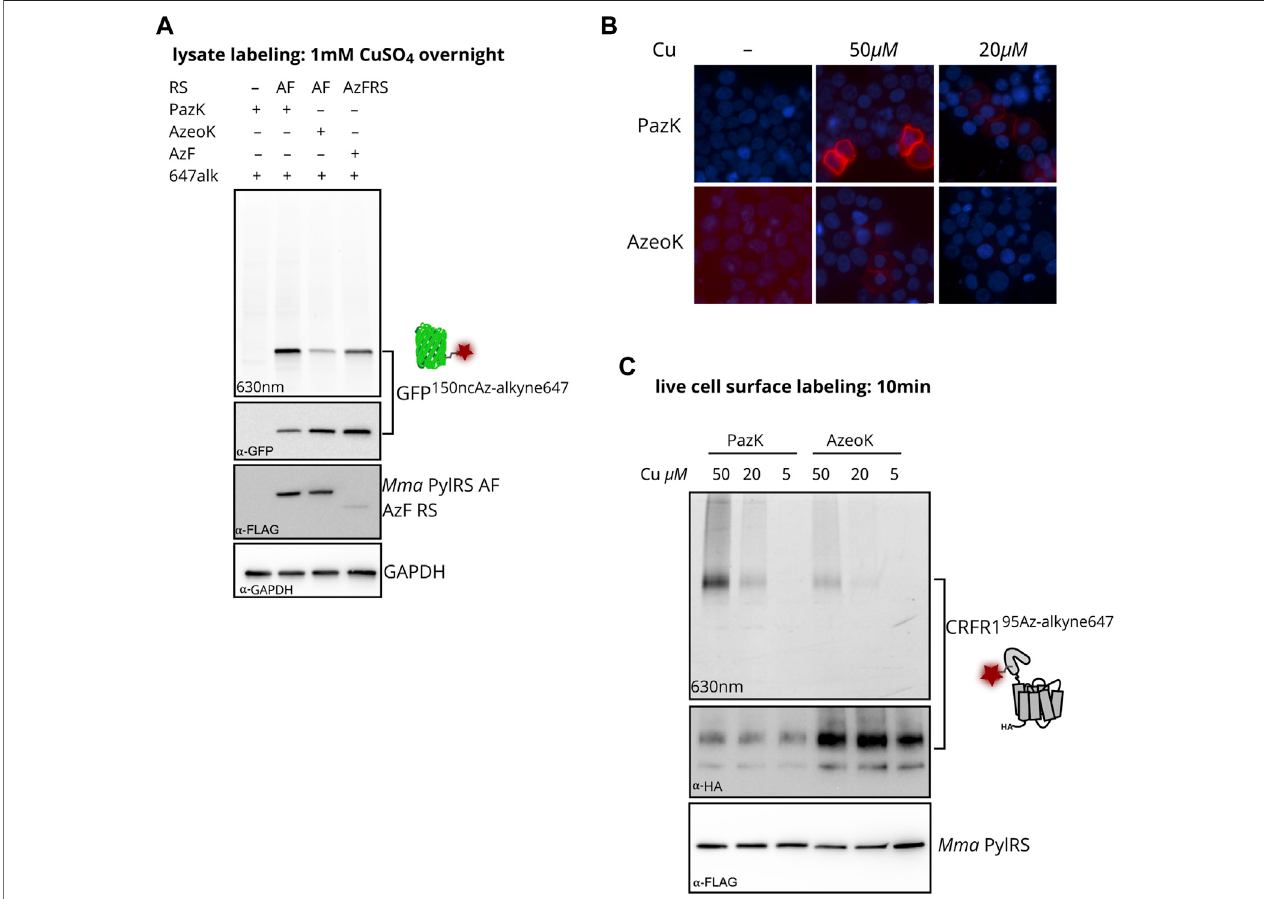
FIGURE 3 | Incorporation of PazK allows copper-catalyzed azide – alkyne cycloaddition (CuAAC) at reduced copper concentrations. (A) CuAAC labeling of azide ncAAs in GFP in HEK293T cell lysate. Cells were transfected with Mma PylT/RS AF, or Bst TyrT/AzFRS and cognate tRNA/GFP150TAG reporter plasmid (1 + 4 ratio) andculturedintheabsence( – ncAA)orpresenceof0.25 mMoftheindicatedncAAfor24 h.CuAAClabelingwith1 mMCuSO 4 ,1 mMTCEP,100 µMTHPTA,and1 µM AF647-alkyne in cell lysate. Lysate aliquots were separated by SDS-PAGE and imaged for in-gel fl uorescence. Immunostaining for GFP, FLAG-tagged aminoacyl- tRNA synthetase, and GAPDH loading control after membrane transfer of the same gel. (B, C) CuAAC labeling of CRFR1 95PazK and CRFR1 95AzeoK on the surface of live HEK293T cells. Cells were transfected with Mma PylT/RS AF and Mma PylT/CRFR1 95TAG reporter plasmid (1 + 4 ratio) and cultured in the absence ( – ncAA) or presence of 0.25 mM of the indicated ncAA for 24 h. CuAAC labeling with 5 – 50 µM CuSO 4 , 25 – 250 µM THPTA, and 5 µM AF647-alkyne on live cells. (B) CuAAC- labeled cells were counterstained with Hoechst 33342, fi xed in 4% formaldehyde for fl uorescence microscopy. (C) Lysate aliquots were separated by SDS-PAGE and imaged for in-gel fl uorescence. Immunostaining for HA-tagged CRFR1 and FLAG-tagged aminoacyl-tRNA synthetase after membrane transfer of the same gel.